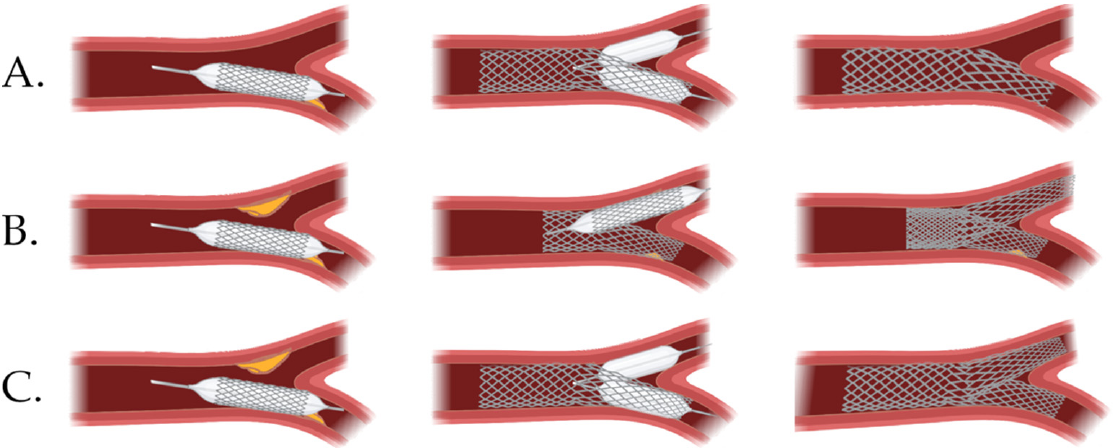
Figure 2. Selected percutaneous coronary intervention bifurcation techniques. ( A ) Provisional stenting, ( B ) culotte, ( C ) double kissing crush.